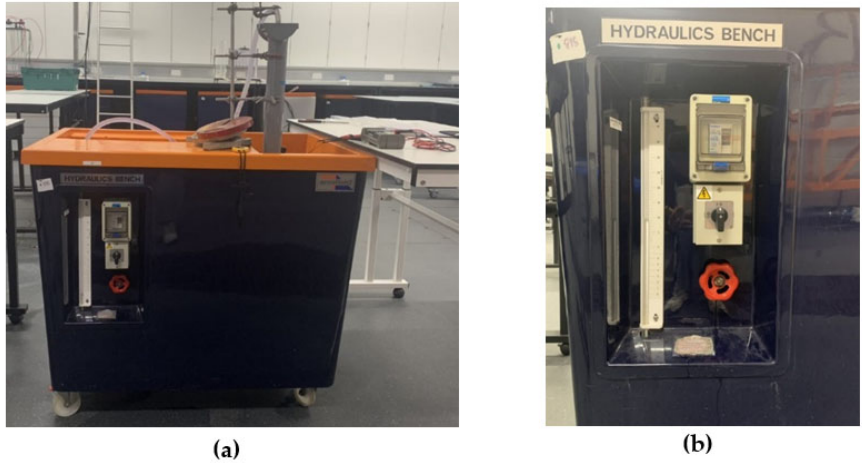
Figure 2. Experimental work: ( a ) experimental setup; ( b ) hydraulic bench control panel.